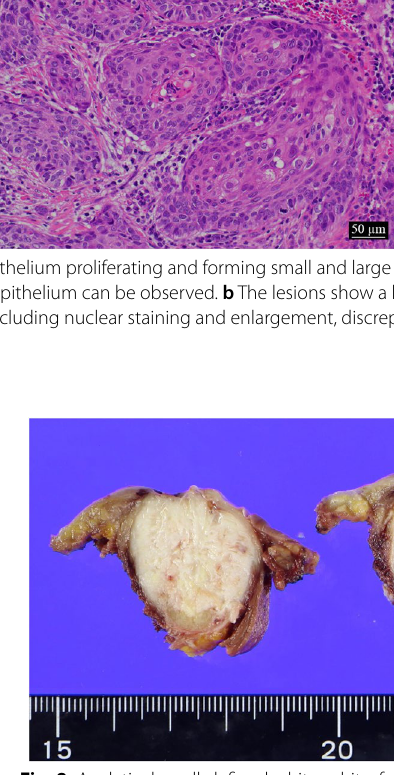
Fig. 8 A relatively well-defined white, white, fulfilling tumor filling the